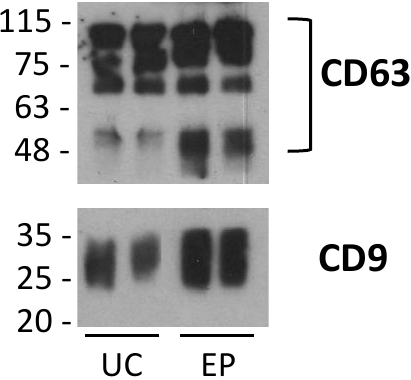
Figure 2. Western blot analysis of plasma EVs isolated from a patient by ultracentrifugation (UC) or Exosome Precipitation kit (EP) with anti-CD9 and anti-CD63 antibodies. The bracket indicates the typical CD63 separation, the smear is likely due to high degree of